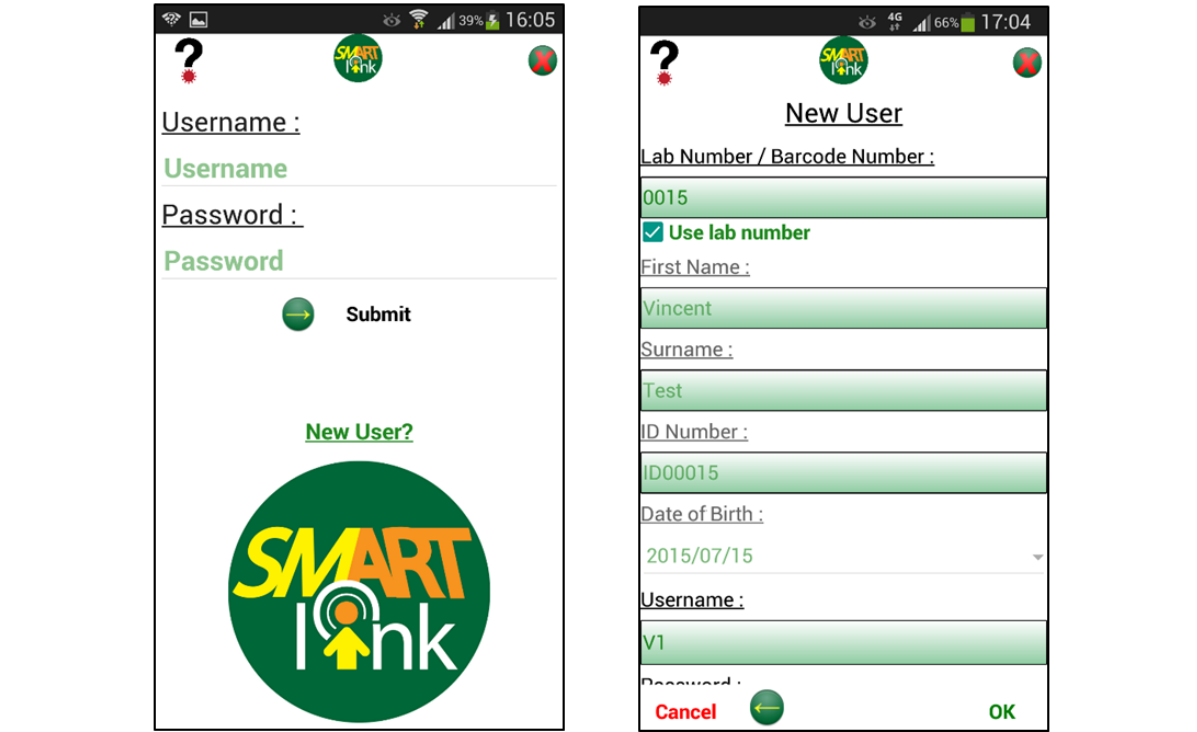
Figure 1. Screenshots of the SmartLink app, showing the login procedure and illustrative home